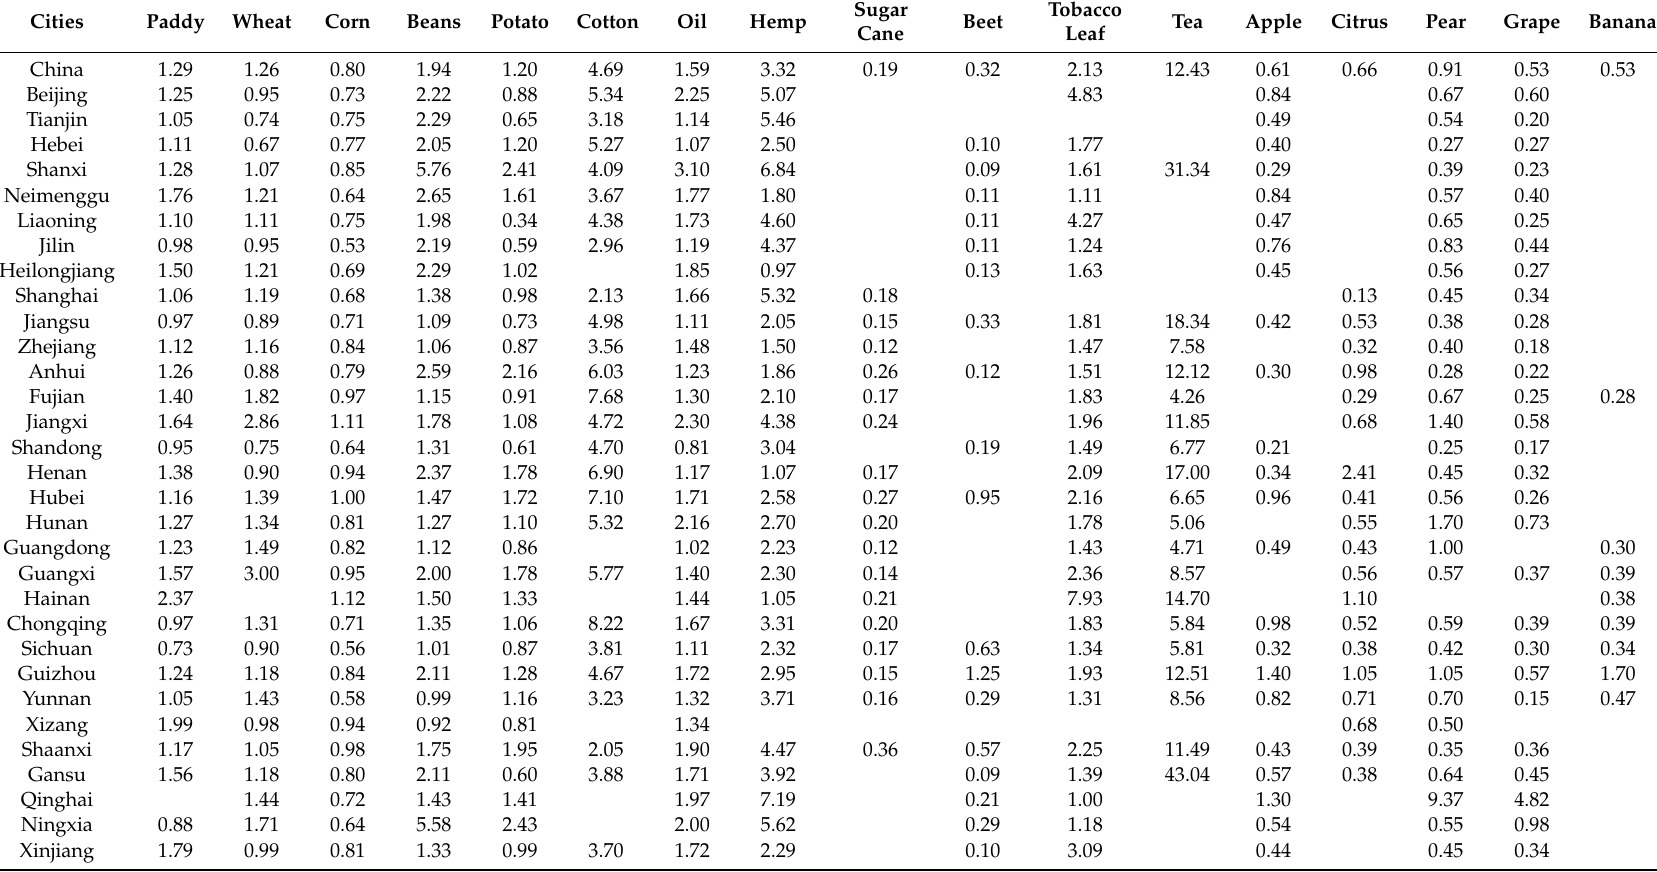
Table 2. Virtual water content of major agricultural product units in various provinces of China (unit: m 3 / kg). Cities